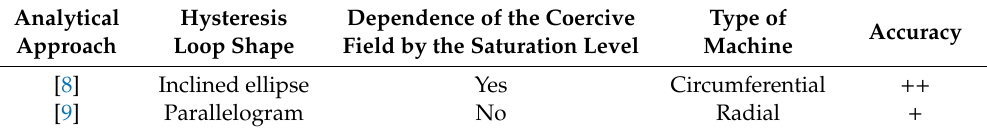
Table 2. Comparison between analytical approaches ( + worst, +++